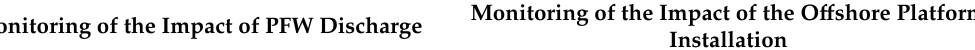
Table 4. List of recommended parameters that should be analyzed for monitoring impacts of o ff shore platform installation and produced formation water (PFW) discharge into the